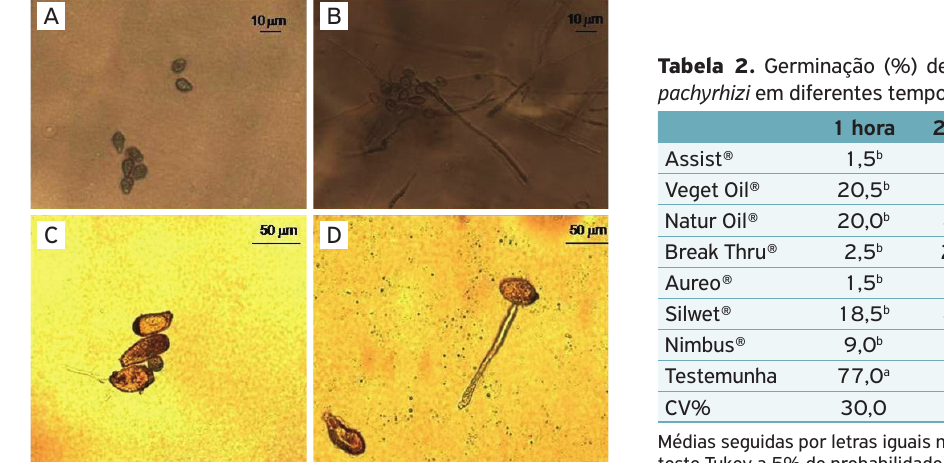
Figura 1. Uredinosporos de Phakopsora pachyrhizi (A e B) e Puccinia kuehnii (C e D) não germinados (A e C) e germinados (B e